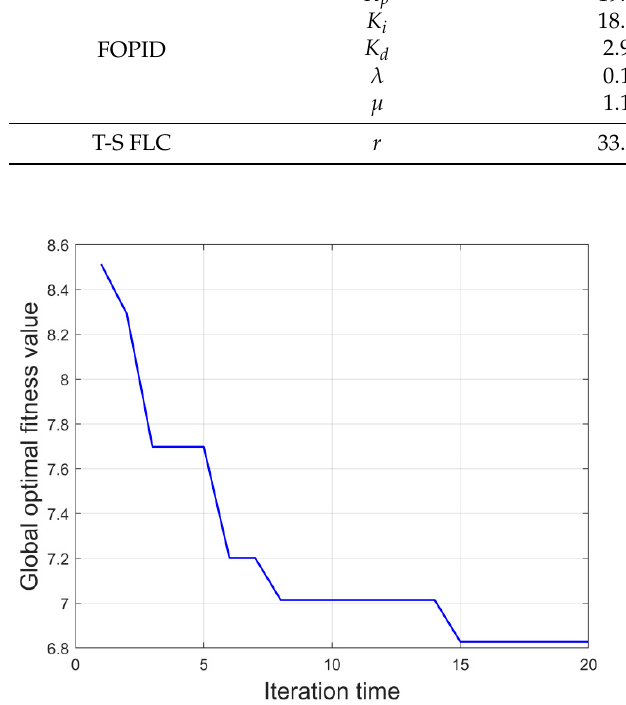
Figure 10. Convergence curve of SIFOFLC system.